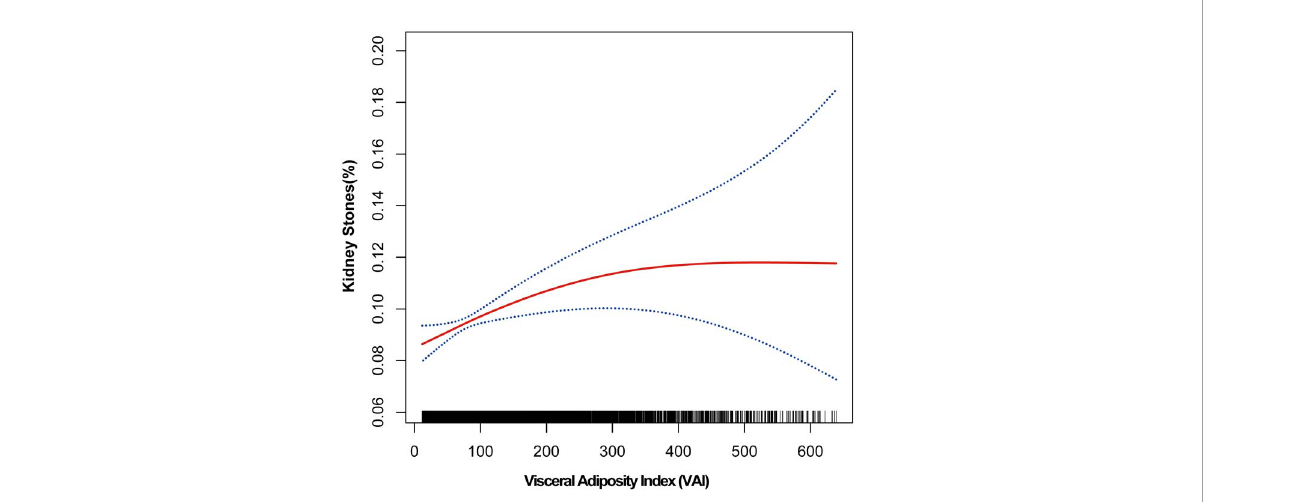
FIGURE1 Smooth curve fitting of kidney stones and VAI Smooth curve fitting was performed using GAM to explore the association between kidney stones and